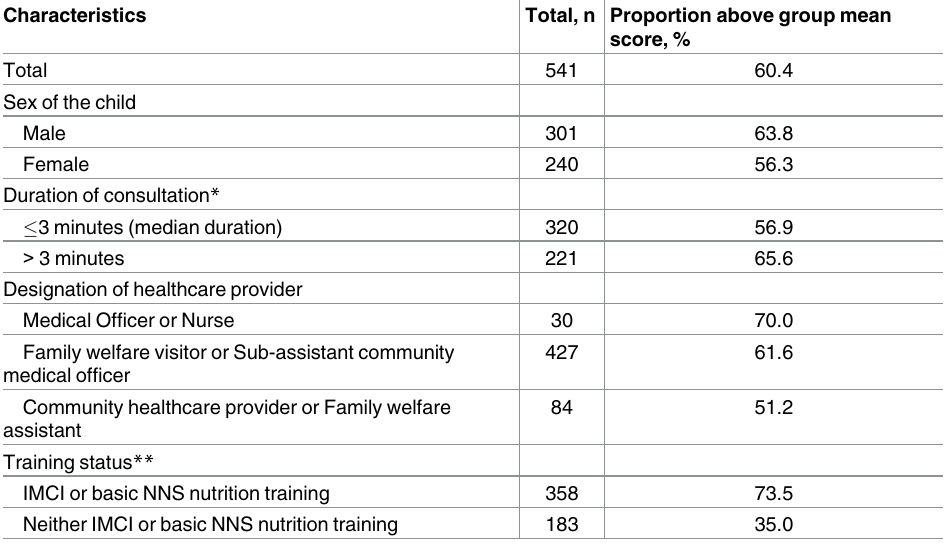
Table 7. Characteristics of mothers/caregiversof sick under-five children having satisfaction above the group mean